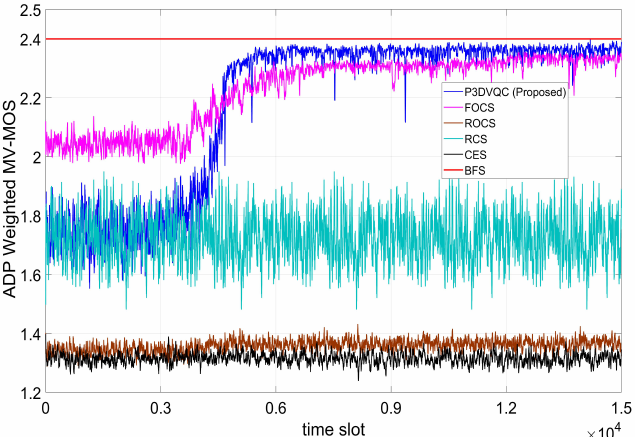
Figure 7. ADP weighted MV-MOS by different kinds of caching